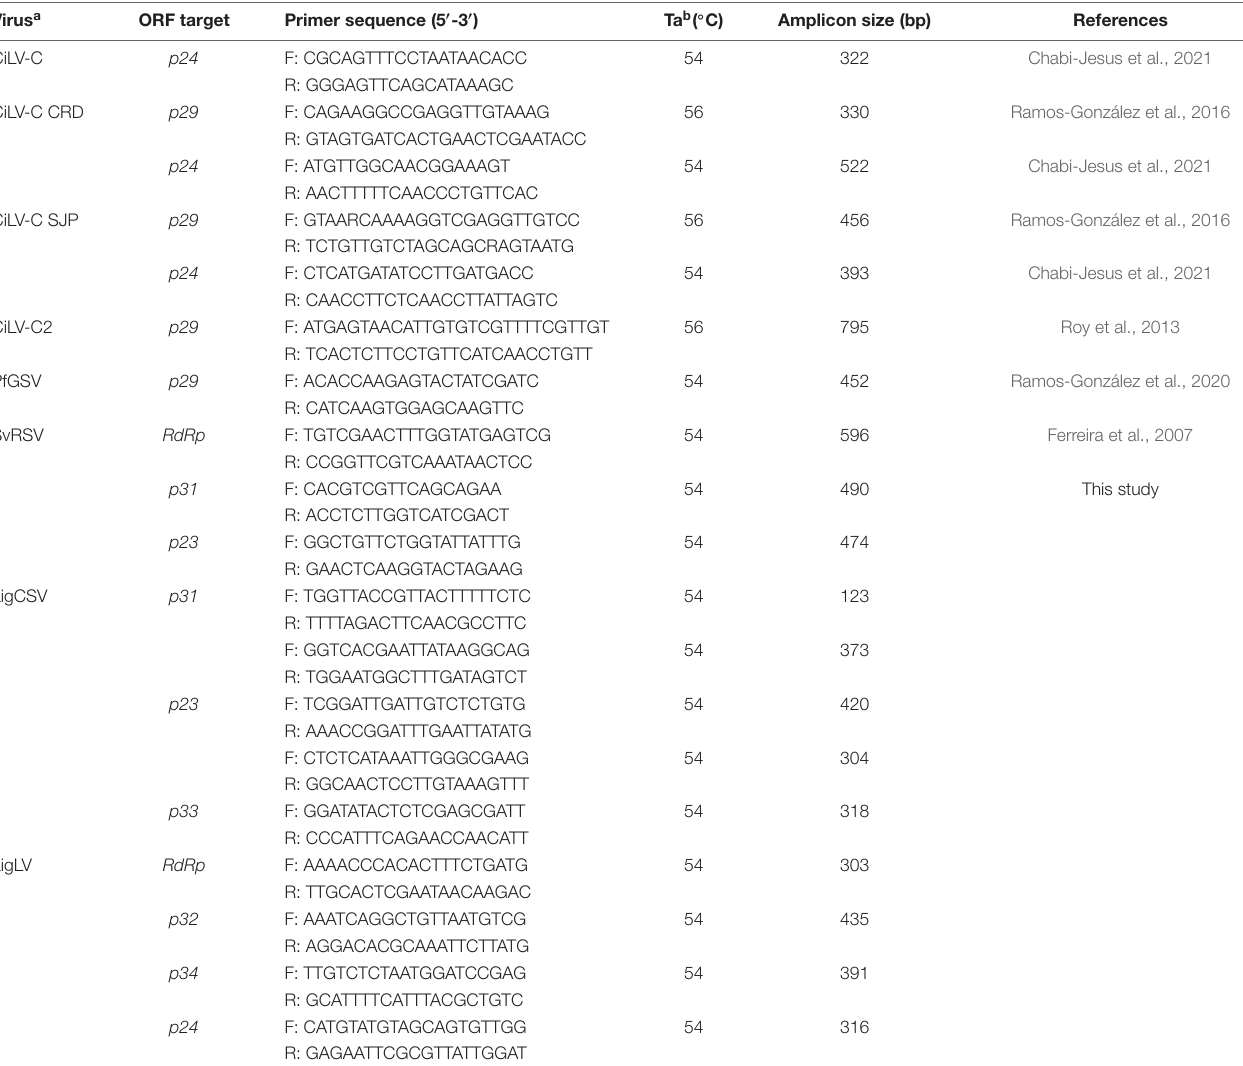
TABLE 1 | List of specific and generic primers for the detection of typical cileviruses and cile-like viruses described in this study. Virus a ORF target Primer sequence (5 (cid:48) -3 (cid:48) )